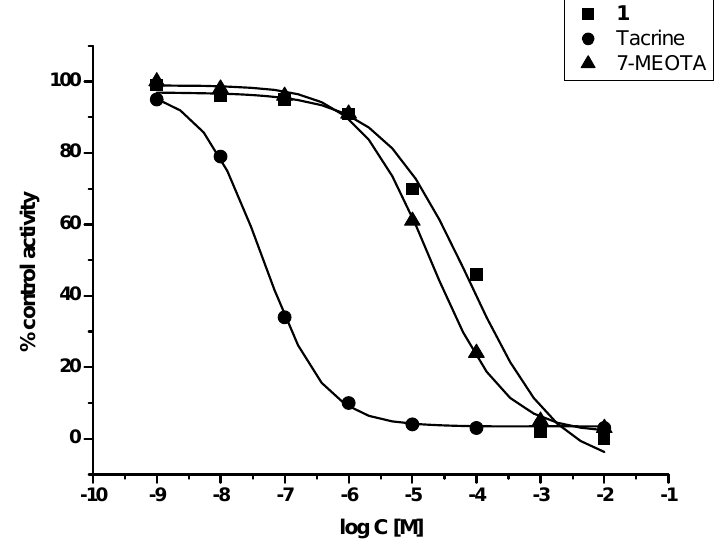
Figure 3. Enzyme activity plot of 1 , THA and 7-MEOTA for